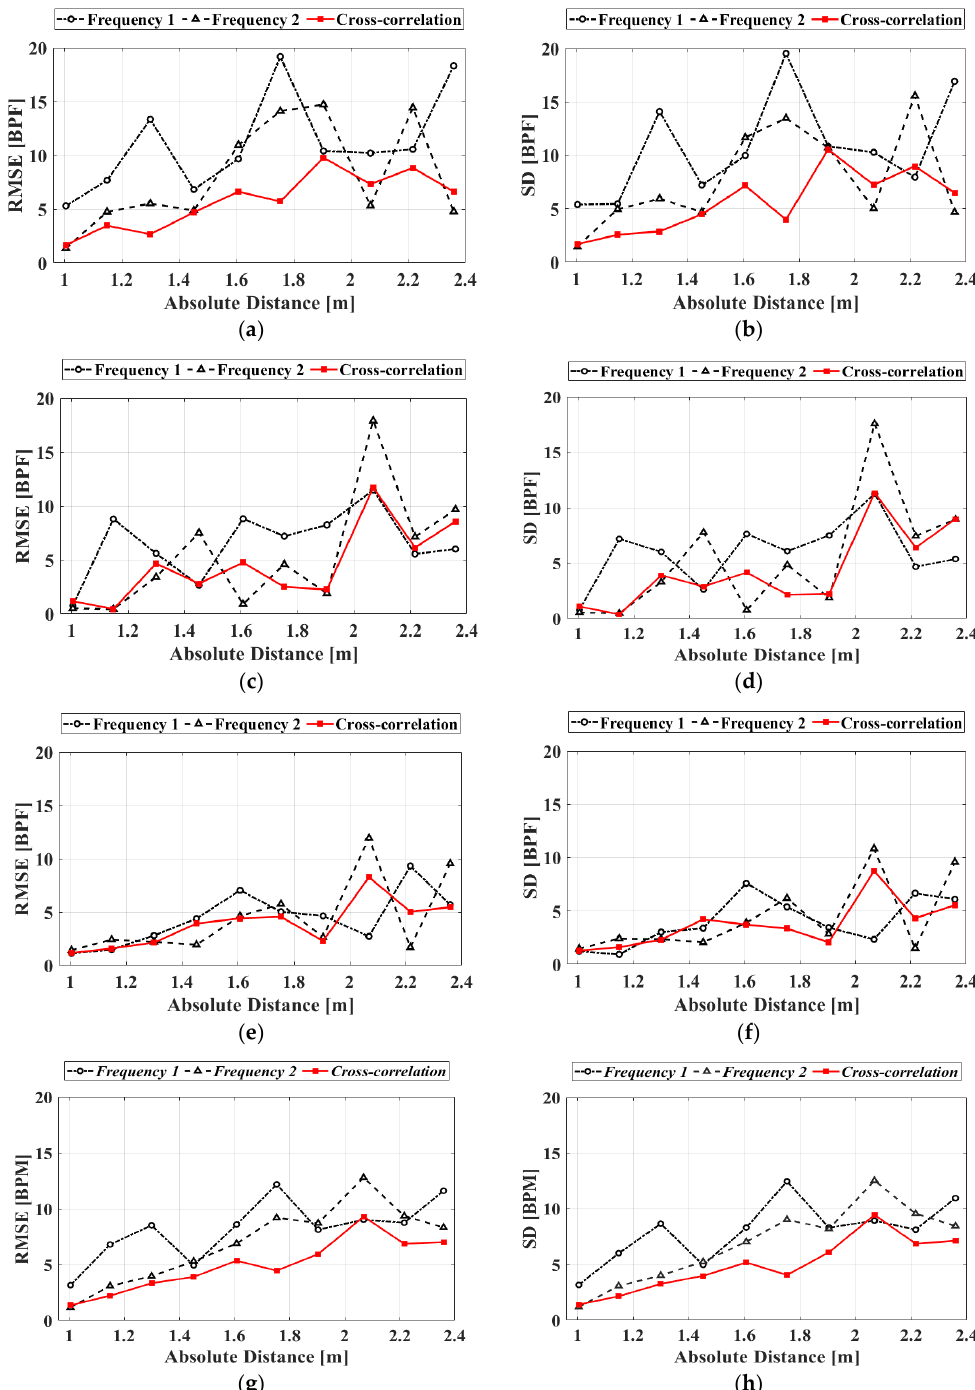
Figure 13. Measured accuracies of the signals obtained at each operating frequency and signals processed with the cross-correlation method in the proposed FSK radar depending on the distance to the subjects: ( a ) Root-mean-square error ( RMSE ) of subject A; ( b ) standard deviation (SD) of subject A; ( c ) RMSE of subject B; ( d ) SD of subject B; ( e ) RMSE of subject C; ( f ) SD of subject C; ( g ) RMSE of the averaged data; ( h ) SD of the averaged